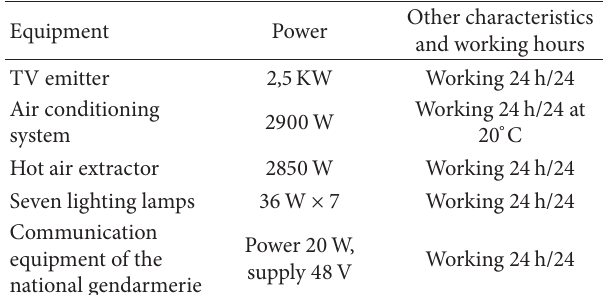
Figure 2: Energy consumption of some telecommunications base stations in the Sahel area of Cameroon.